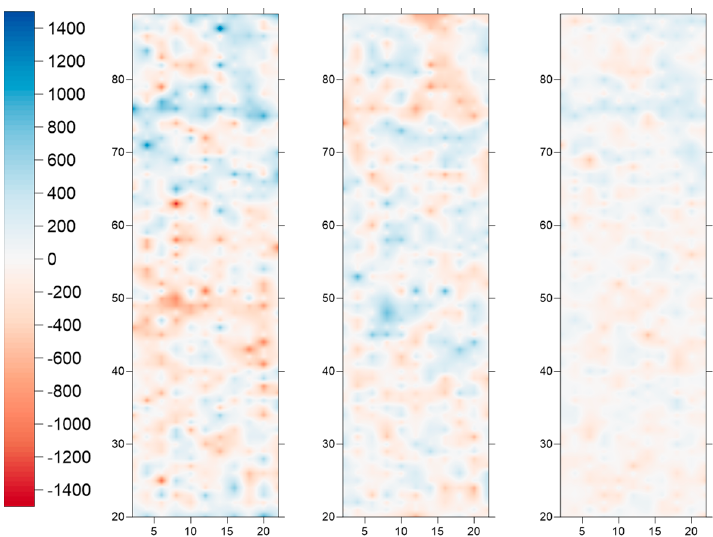
Figure 13. Errors observed between the GPR in measurements (see Figure 12a–c) and the BNN fusion model (see Figure 12d–f) for the depth slices between 0.00–0.20 m ( a ), 0.20–0.40 m ( b ), and 0.40–0.60 m ( c ). Higher amplitude error values are shown with red colour while lower amplitude error values with blue.